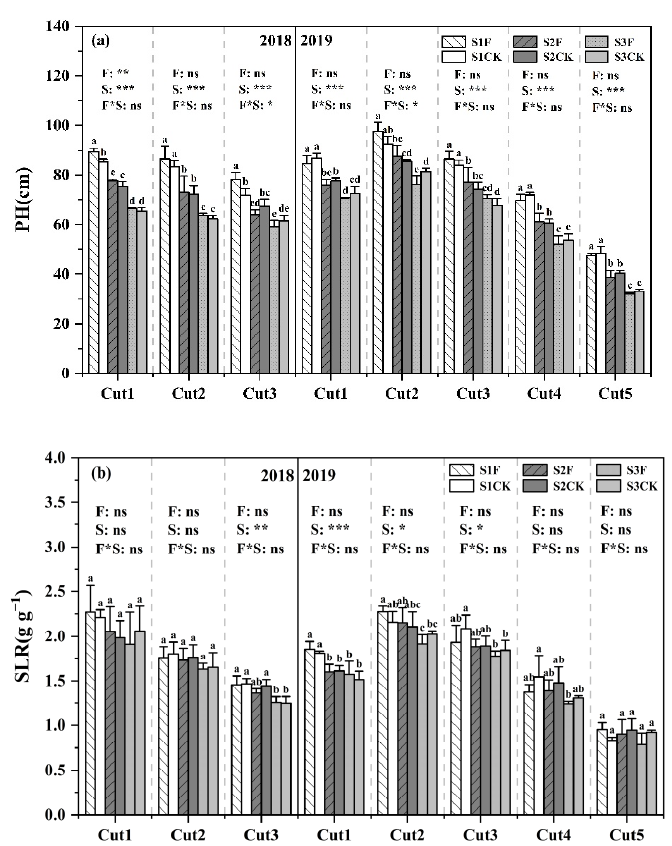
Figure 2. Alfalfa plant height (PH, ( a )) and stem-leaf ratio (SLR, ( b )) of each cut under different treatments in 2018 and 2019, along with their ANOVA results. The error bars represent the standard deviation ( n = 3), and columns with different letters significantly differed at p < 0.05. F: biosolids fertilizer treatment; S: salinity treatment; F*S: the interaction of biosolids fertilizer and salinity. ns, non-significant; *, **, and *** indicate significances at p < 0.05, p < 0.01, and p < 0.001 levels of ANOVA analysis, respectively.